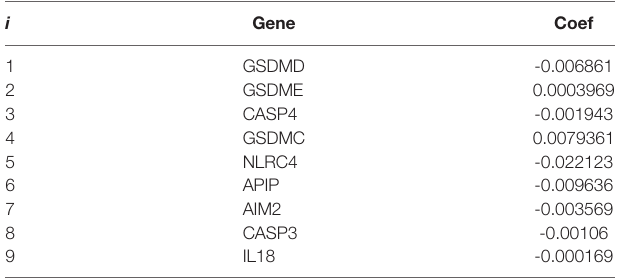
TABLE 2 | Coef fi cients in the LASSO Cox regression